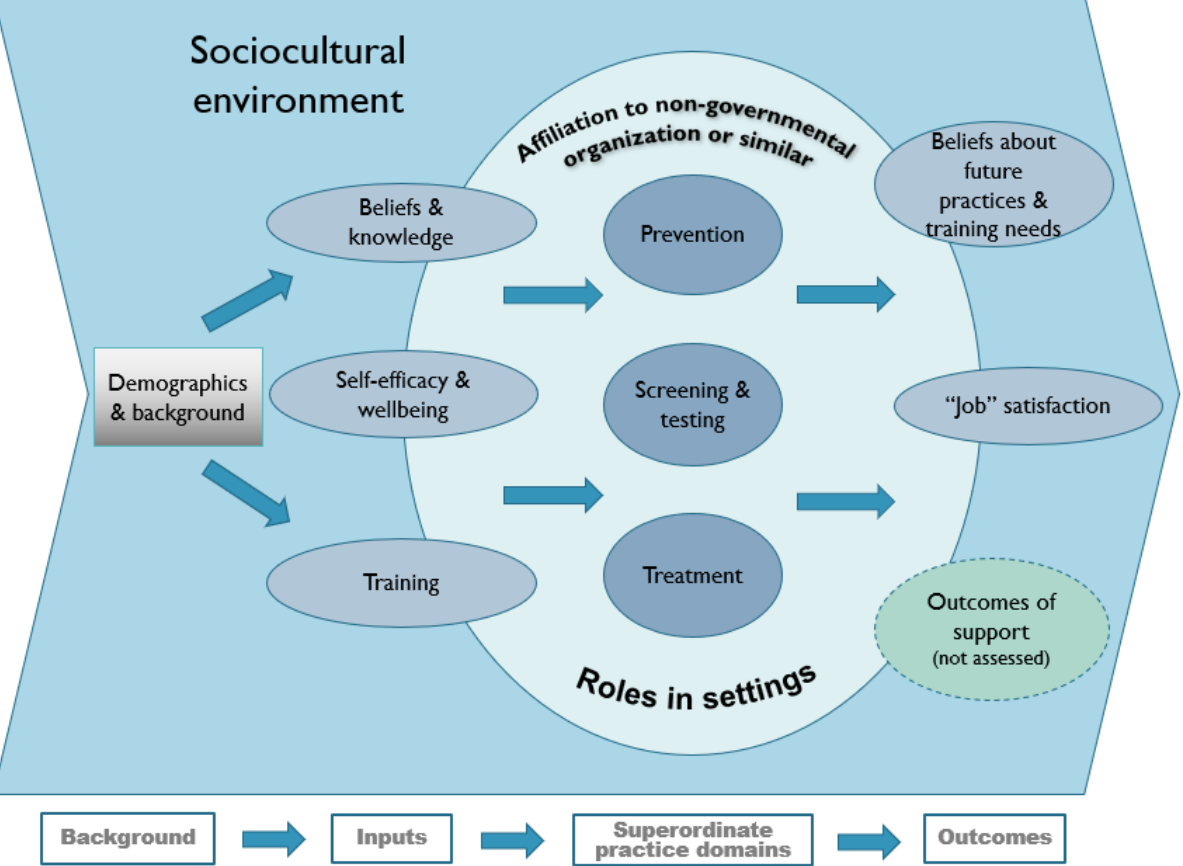
Figure 1. Diagram of ECHOES conceptual